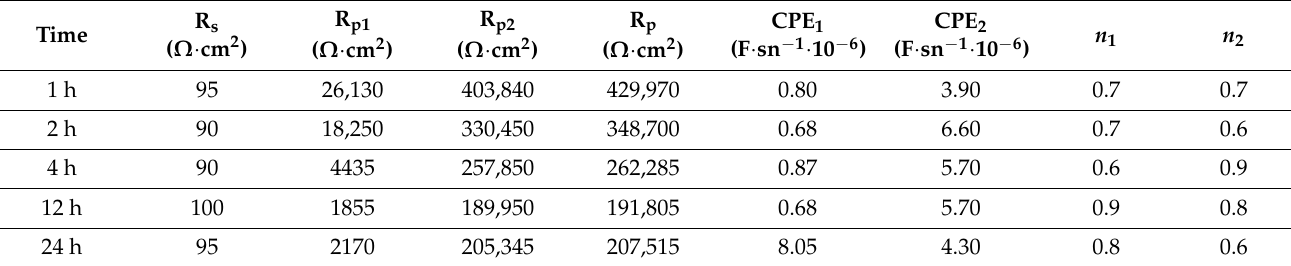
Table 4. Electrochemical characteristics of PEO coated surface in 0.1 M